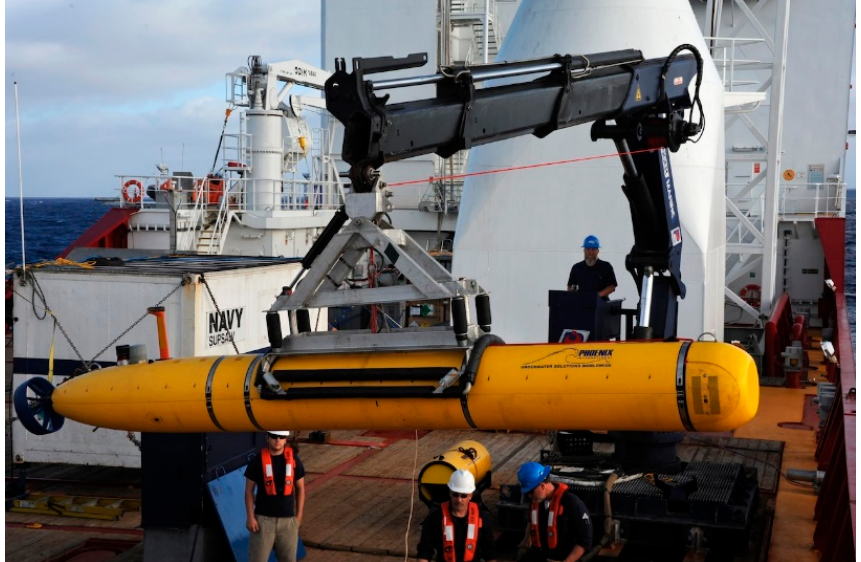
Figure 1. The propeller and control surfaces of unmanned underwater vehicles [5] generally utilize DC motors [6] like those depicted in Figure 2. Credit: Navy photo by Petty Officer 1st Class Peter D. Blair. Department of Defense photographs and imagery, unless otherwise noted, are in the public domain [7].